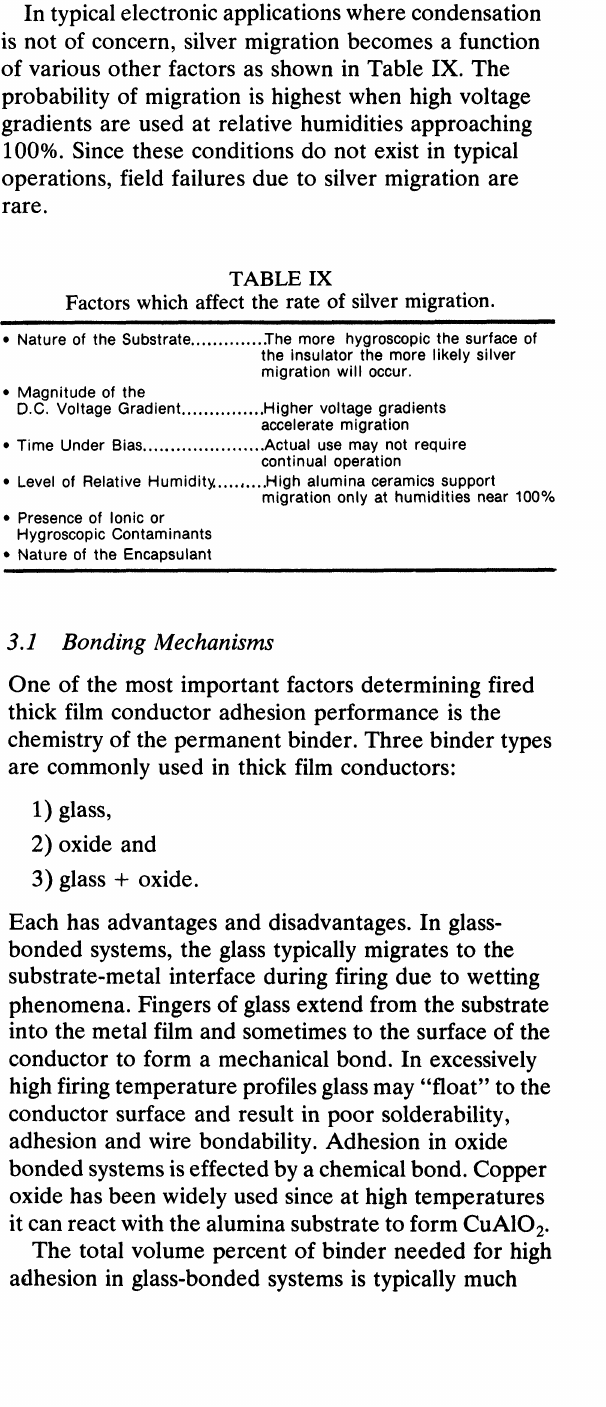
TABLE IX Factors which affect the rate of silver